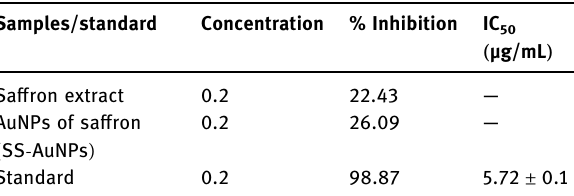
Table 5: Analgesic activity of sa ff ron extract and SS - AuNPs Treatment